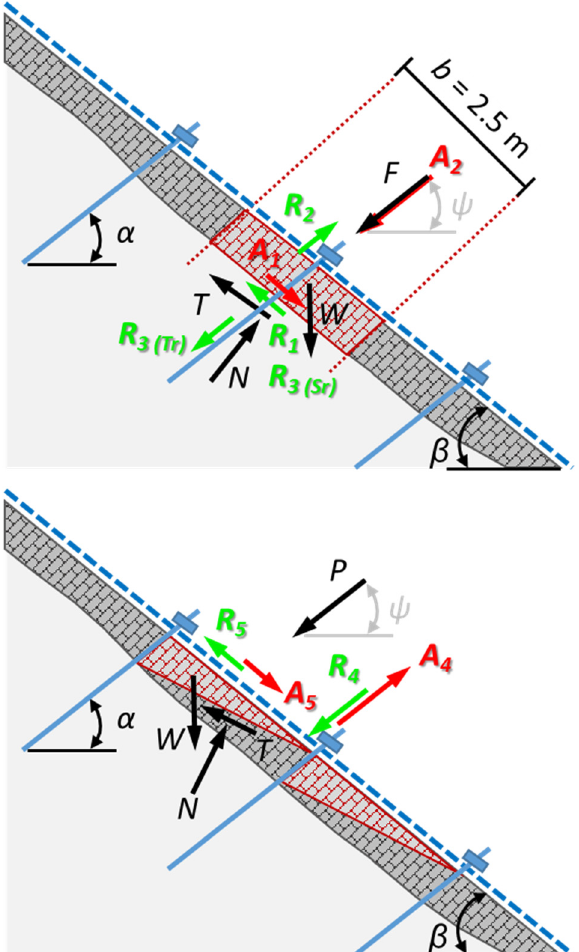
Figure 3. Example 1: hazard zoning obtained along the slope without and with the effects of a pro- tection system installed at the rock fall source area. The mitigation effects all over the slope are illustrated with reference to the Swiss rock fall intensity–frequency diagram.